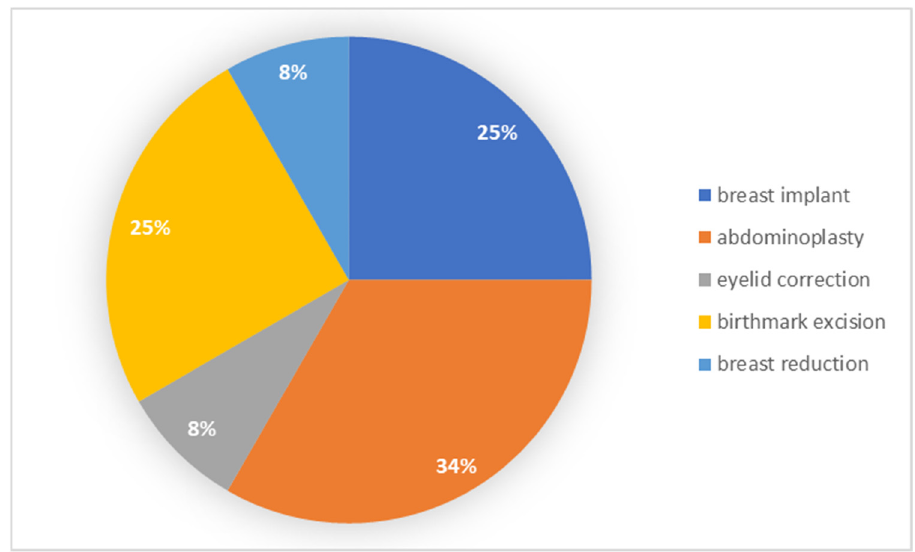
Figure 2. Types of procedures performed by patients with vocational education. Patients with secondary education most often underwent breast implantation and breast reduction. The results of the frequency of each type of surgery among individual groups are presented in Figure 3.